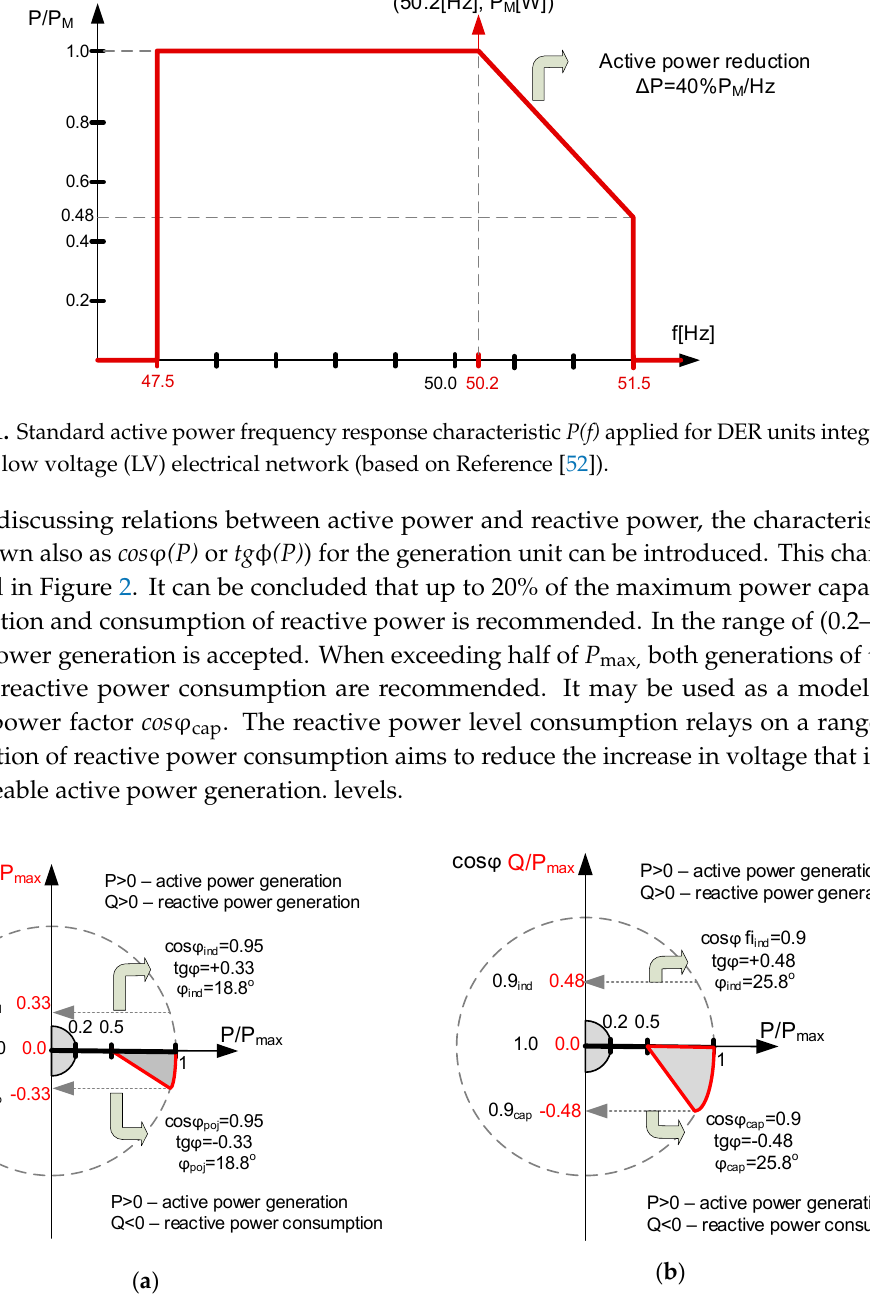
Figure 2. Standard Q/P max profile ( cos φ ( P ) characteristic) applied for distributed energy resource (DER) units integrated with a LV electrical network: ( a ) with regard to units with a maximum power capacity of 3.68 kVA to 13.8 kVA; ( b ) with regard to units with the maximum power capacity over 13,800 VA (based on References [52,57]).